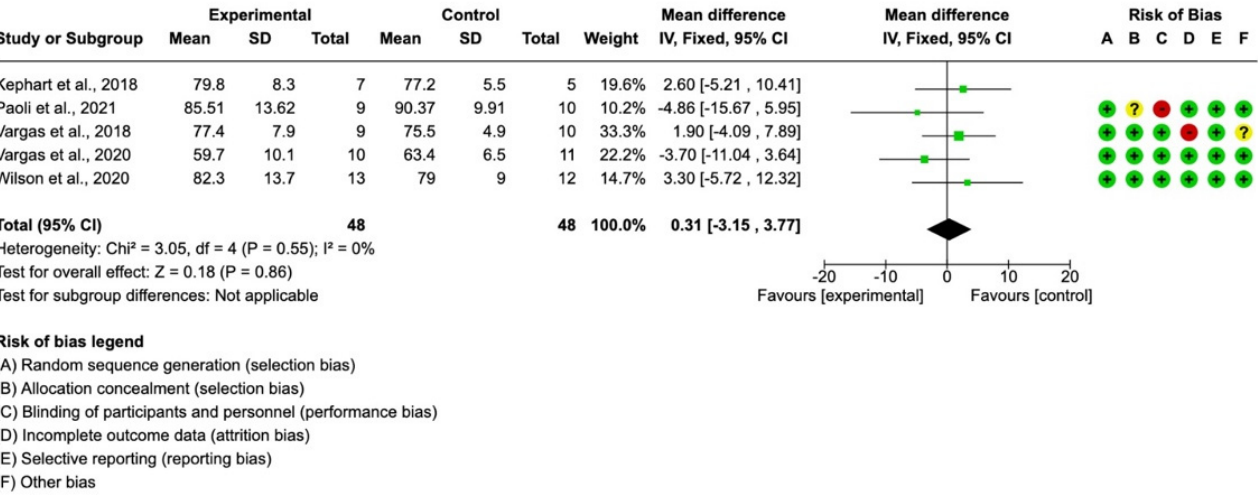
Figure 2. Forest plot for weight [12,14,27–29].